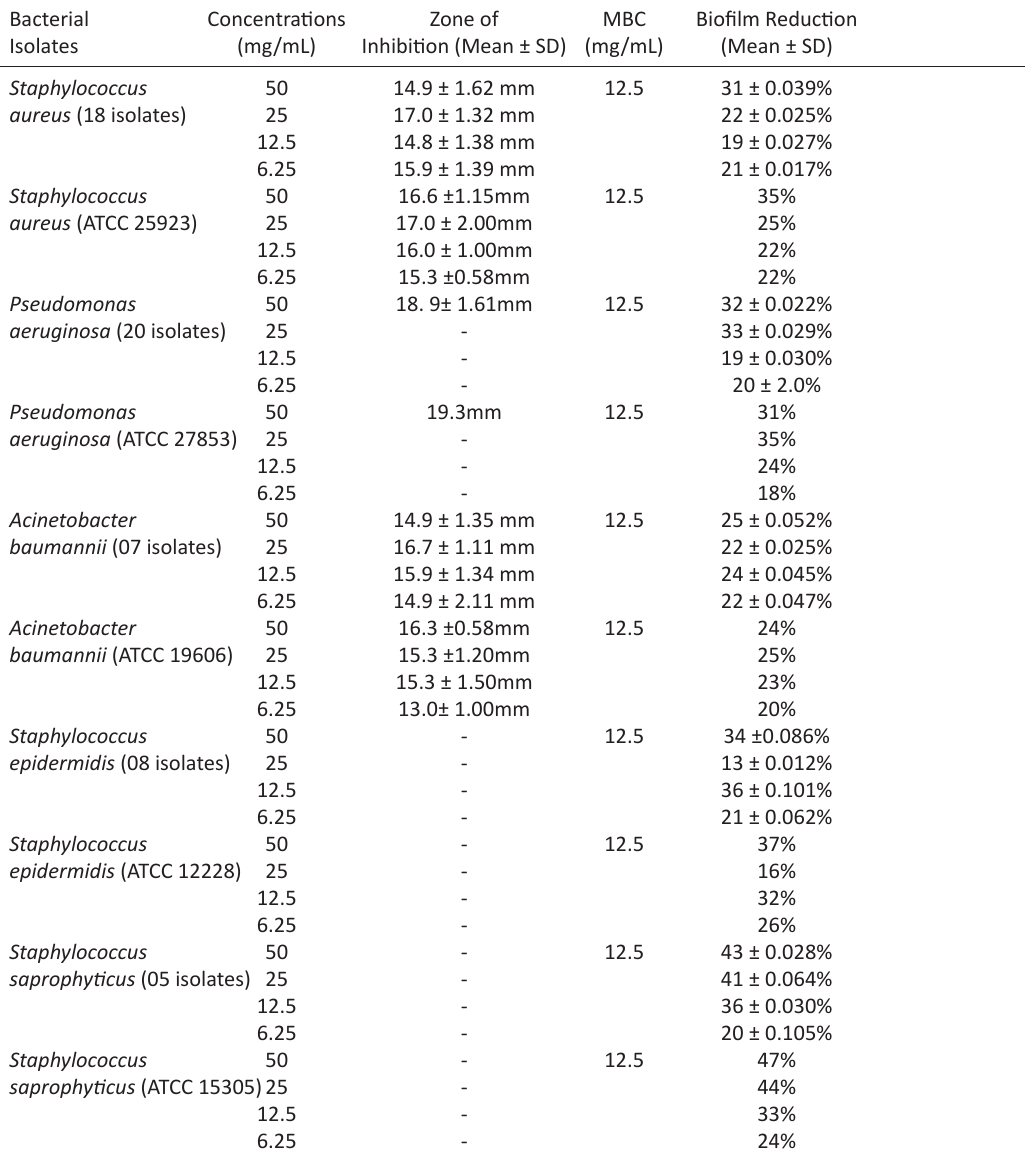
Table 4. Antibacterial and antibiofilm activity of Allium sativum Bacterial Concentrations Zone